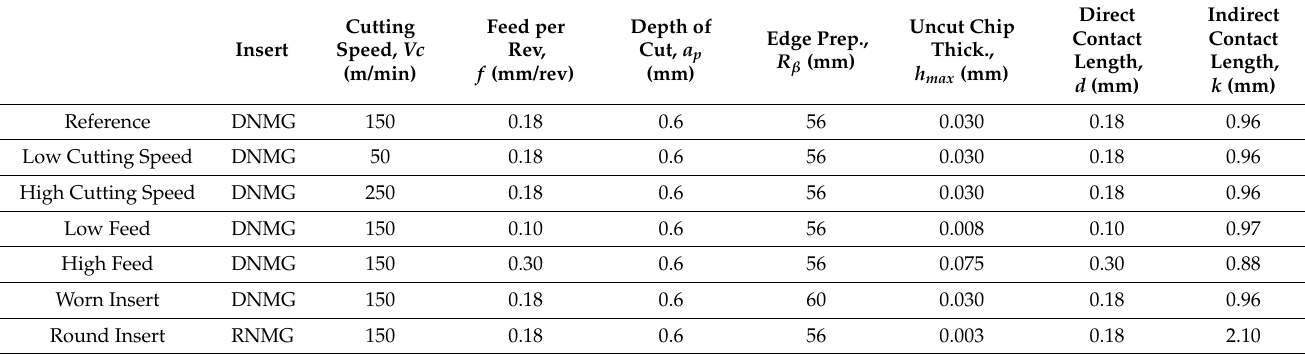
Table 7. Cutting conditions for orthogonal tests and geometrical parameters measured during experiments.